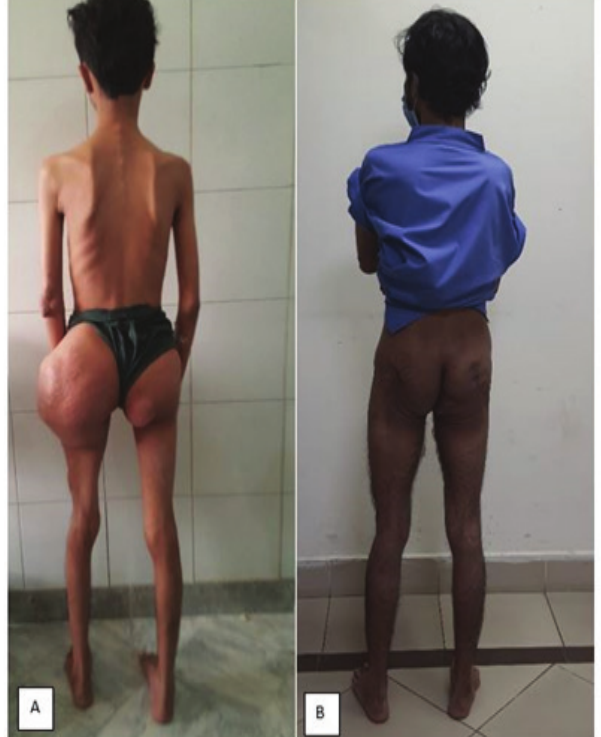
Figure-III: A) Preoperative photograph at presentation in 2017 B) Postoperative follow up photograph in January